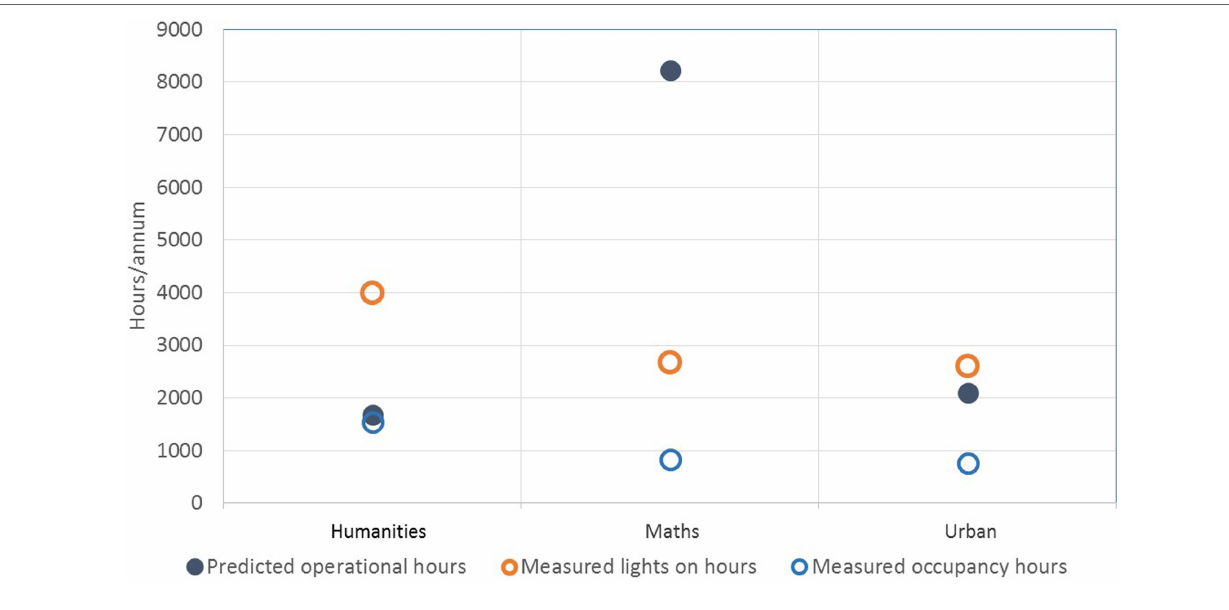
FigUre 12 | Annual hours of lighting and occupancy across three